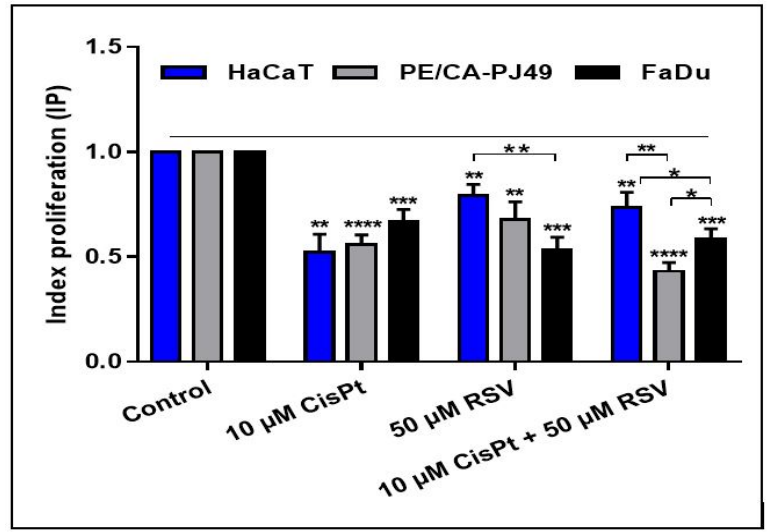
Figure 1. The index of proliferation (IP) for tumor cell line PE/CA-PJ49, FaDu and normal cell line HaCaT treated with RSV and/or CisPt for 24 h. IP is equal to absorbance of treated cells/absorbance of untreated cells. Results are expressed as absorbance mean values of three determinations +/− standard deviation (SD). Untreated cells are considered to have an IP equal 1. (* p < 0.05, ** p < 0.005, *** p < 0.0005; **** p < 0.00005).